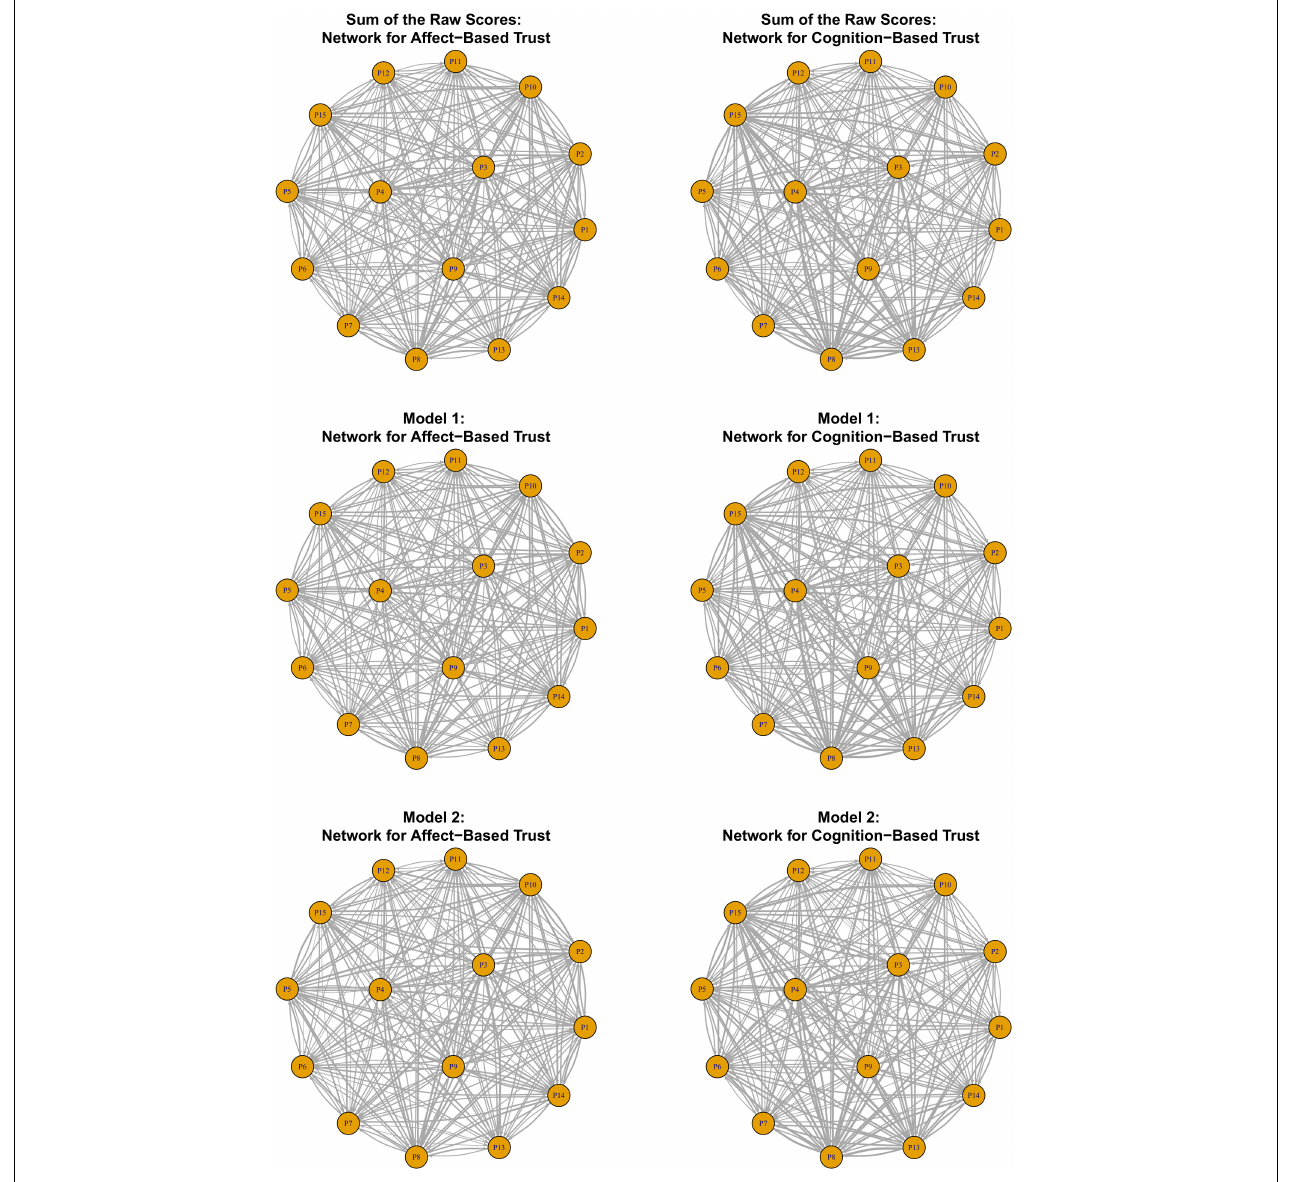
FIGURE 3 | Affect-based trust networks and cognition-based trust networks generated from the raw scores and the estimates from Model 1 and Model